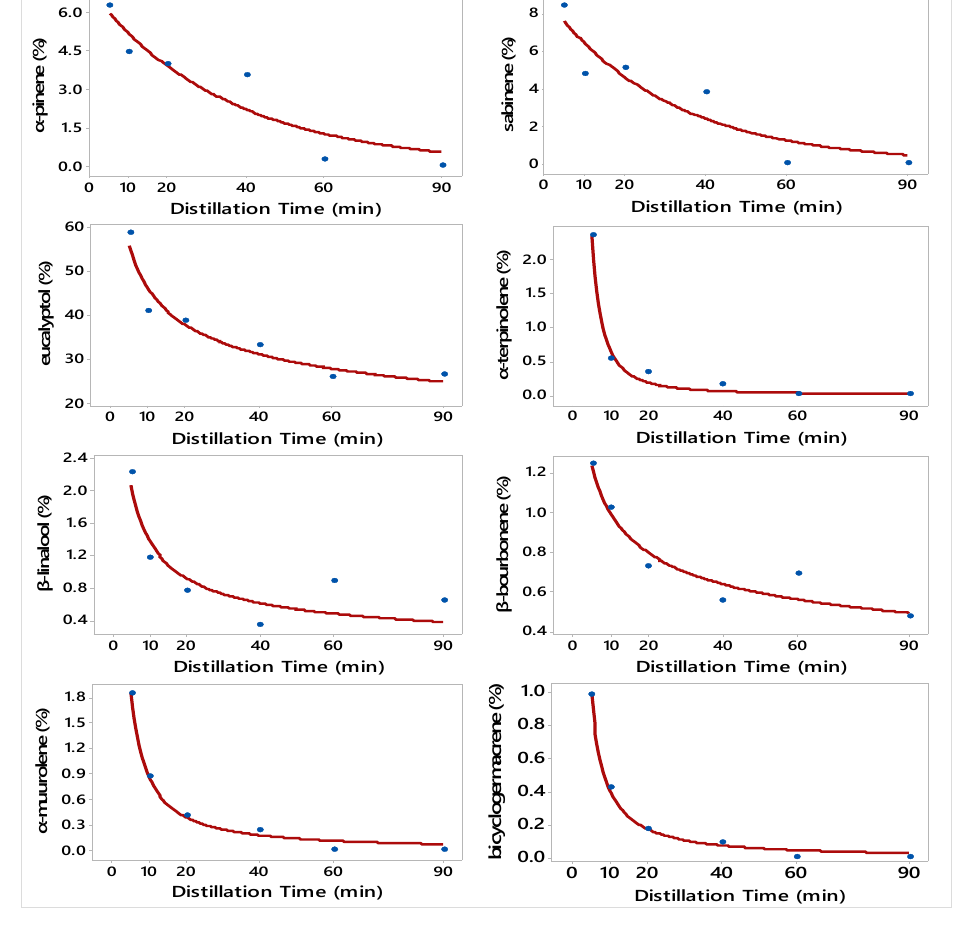
Figure 3. Plot of Distillation Time vs. the concentrations of eight constituents of H. officinalis subsp. aristatus along with the fitted Exponential and Power nonlinear regression models. The fitted models are: ˆ Y = 6.88 Exp ( − 0.0284 DT ) ( α -pinene), ˆ Y = 8.95 Exp ( − 0.033 DT ) (sabinene), ˆ Y = 88.2 DT − 0.2833 (eucalyptol), ˆ Y = 48.4 DT − 1.883 ( α -terpinolene), ˆ Y = 5.22 DT − 0.5801 ( β -linalool), ˆ Y = 2.05 DT − 0.316 ( β -bourbonene), ˆ Y = 11.4 DT − 1.132 ( α -muurolene), and ˆ Y = 7.625 DT − 1.266